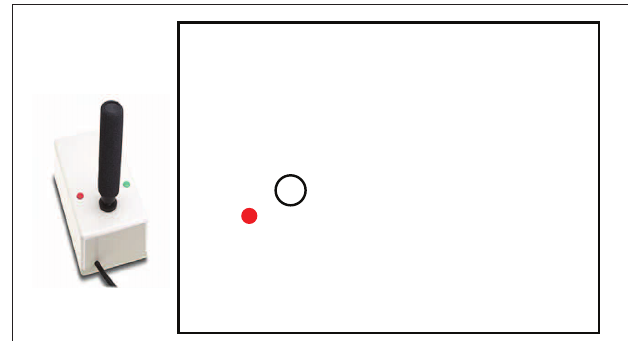
FIGURE 1 | Task paradigm of Experiment 1. Participants were instructed to continuously track a moving target across the computer monitor using a